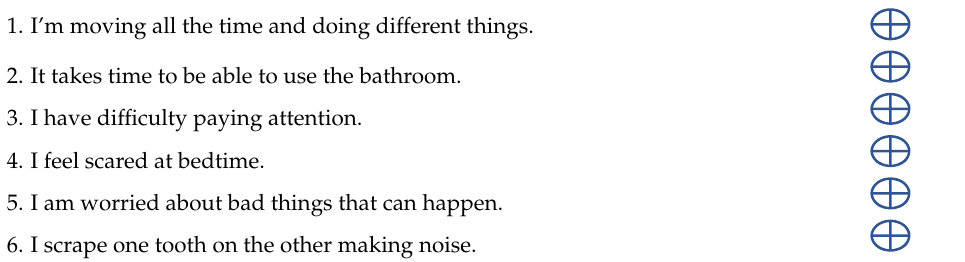
Table A2. Data collection instrument for the Infantile Stress Scale.